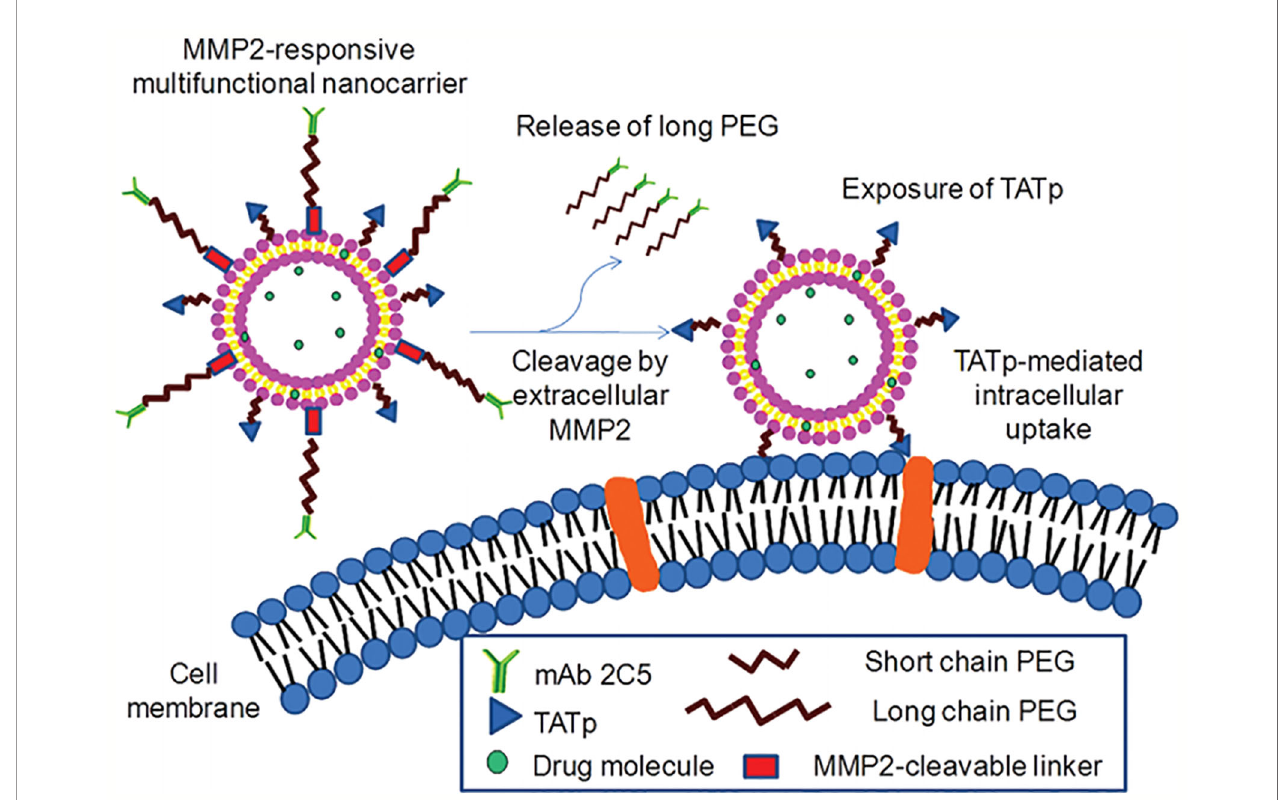
FIGURE 7 | MMP2-responsive multifunctional liposomal nanocarrier and its drug delivery strategy (Zhu et al., 2012) (with reproduction